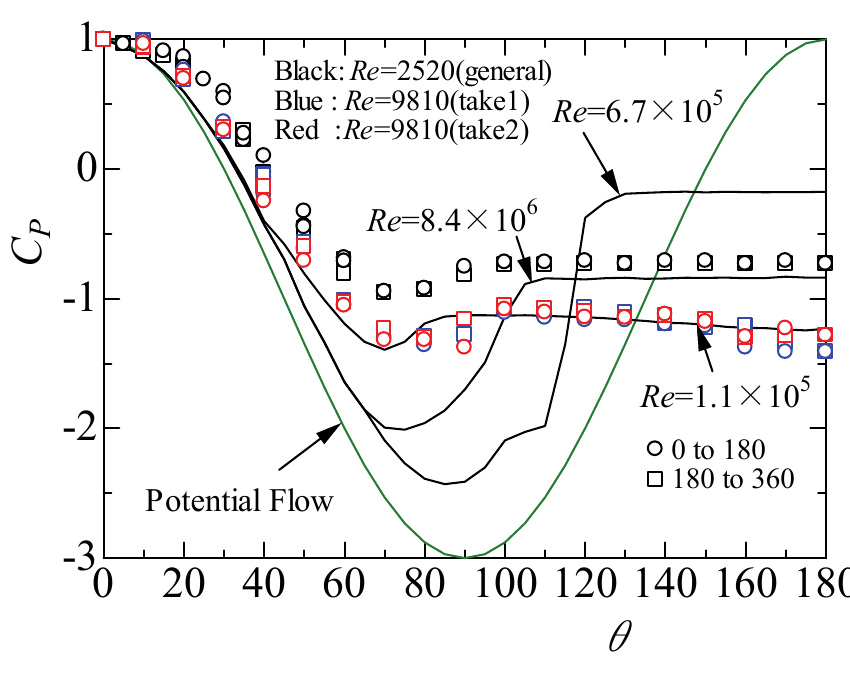
Fig. 4. The pressure coefficient distribution on the surface of a circular cylinder; comparison with the results measured by this technique, and previous measurement results